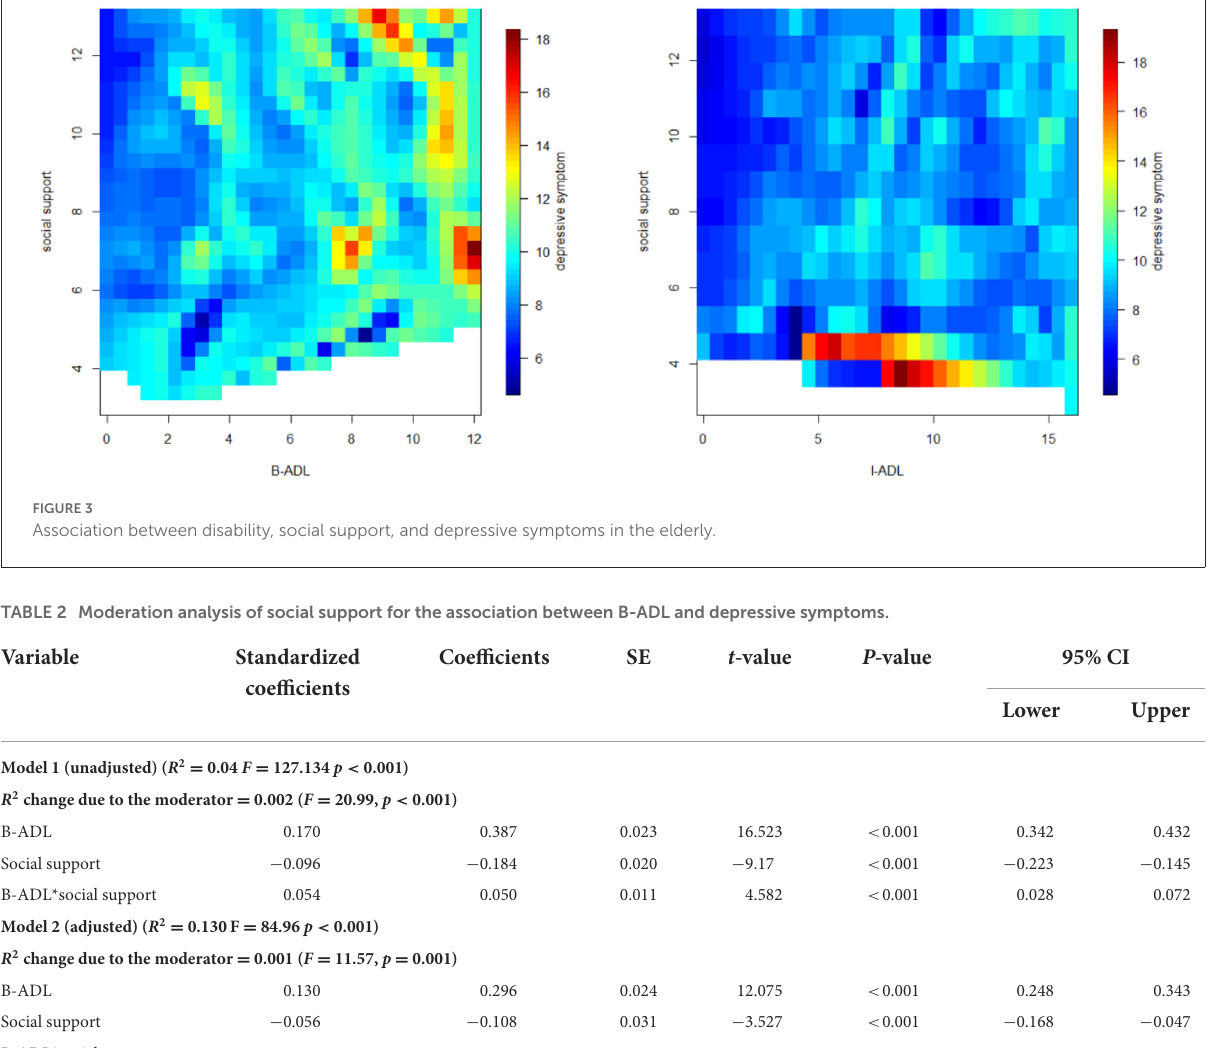
Figure 2 indicated that social support ( r = − 0.13, P < 0.001) was significantly correlated with depressive symptoms. Specifically, sick care ( r = − 0.14, P < 0.001), contact1 ( r = − 0.11, P < 0.001), contact2 ( r = − 0.11, P < 0.001), and contact3 ( r = − 0.10, P < 0.001)